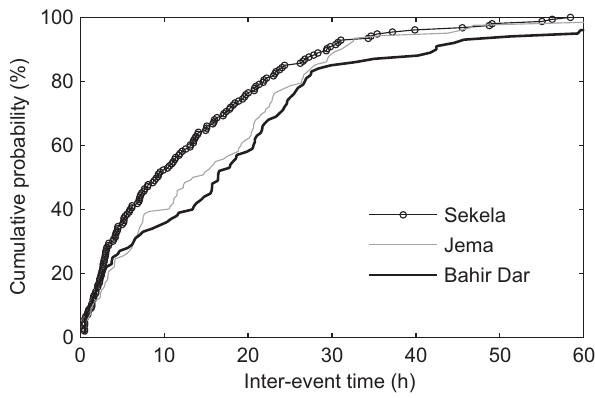
Fig. 4. Box-whisker plot of mean event rain rate in JJA of 2007 as Fig. 4 Box-whisker plot of mean event rain rate in JJA of 2007 as observed at eight 750 rain gauge stations. 751 observed at eight rain gauge stations. 752